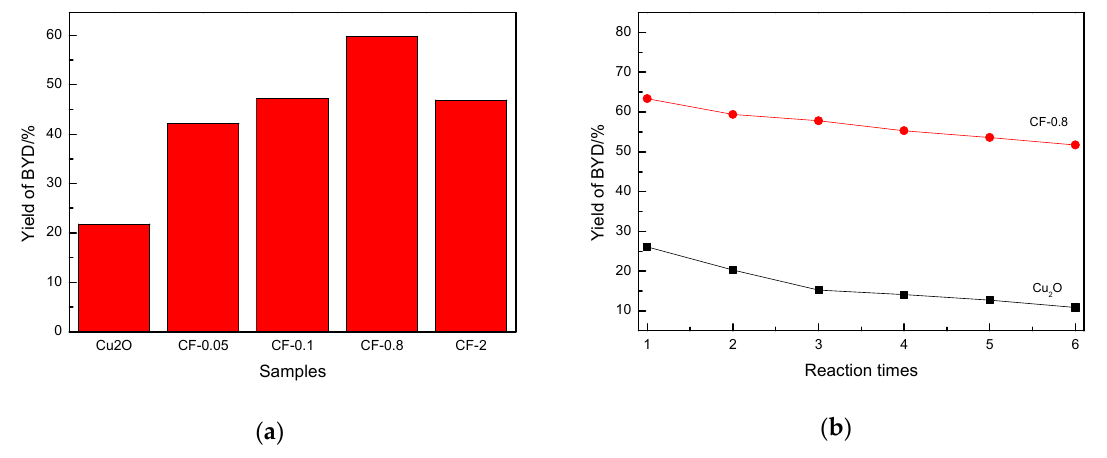
Figure 8. Catalytic performances of Cu 2 O and Cu x O-Fe y O z .